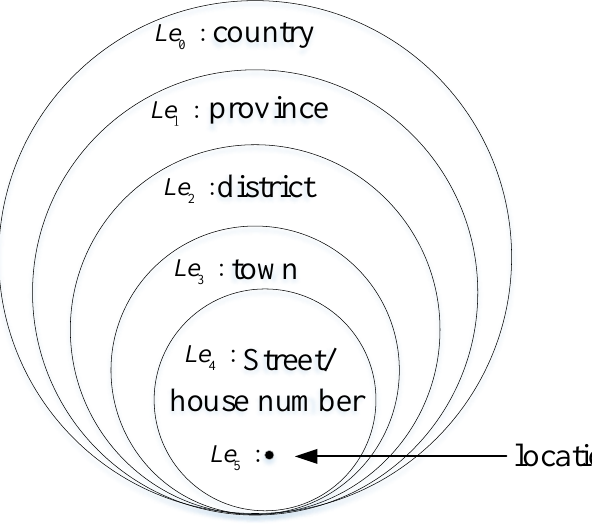
Figure 2. Hierarchical structure of the